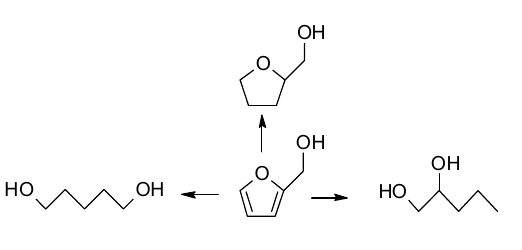
Scheme 1. Schematic overview on the products available via hydrogenolysis or hydrogenation of furfuryl alcohol.